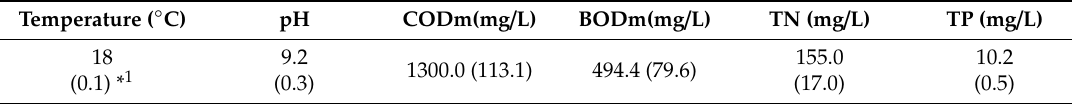
Table 1. Mean and standard deviation of indicators of water quality before the implementation of the present study on the 21 st of July 2011. Chemical oxygen demand (COD); biological oxygen demand (BOD); total nitrogen (TN), and total phosphate